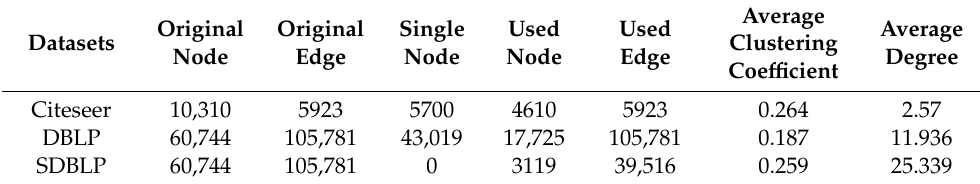
Table 2. Dataset